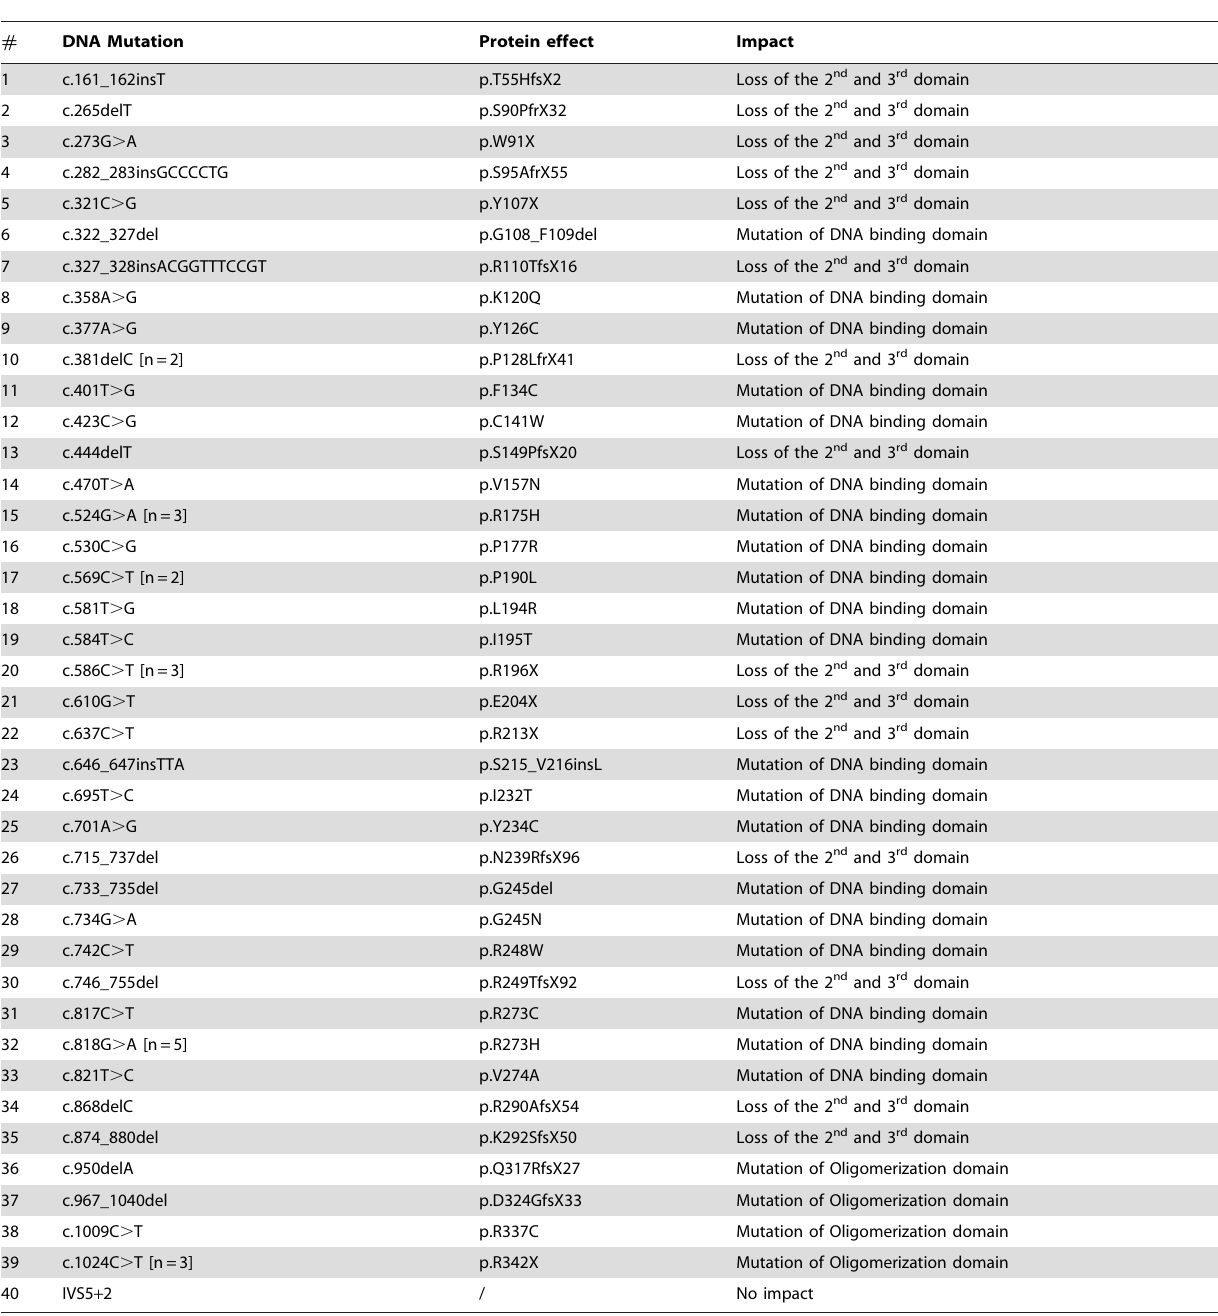
Table 2. Detail of observed TP53 gene